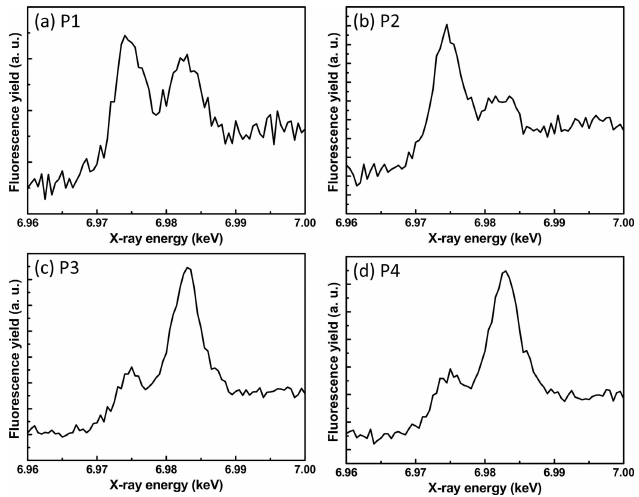
Figure 5 ( a )–( d ) XAS spectra of local areas P1–P4 marked with the white dashed circles in Figs. 3( a )–3( d ). The coexistence of the two common valence states of Eu 2+ and Eu 3+ can be seen in the XAS spectra of P1–P4, represented by the two well resolved edge